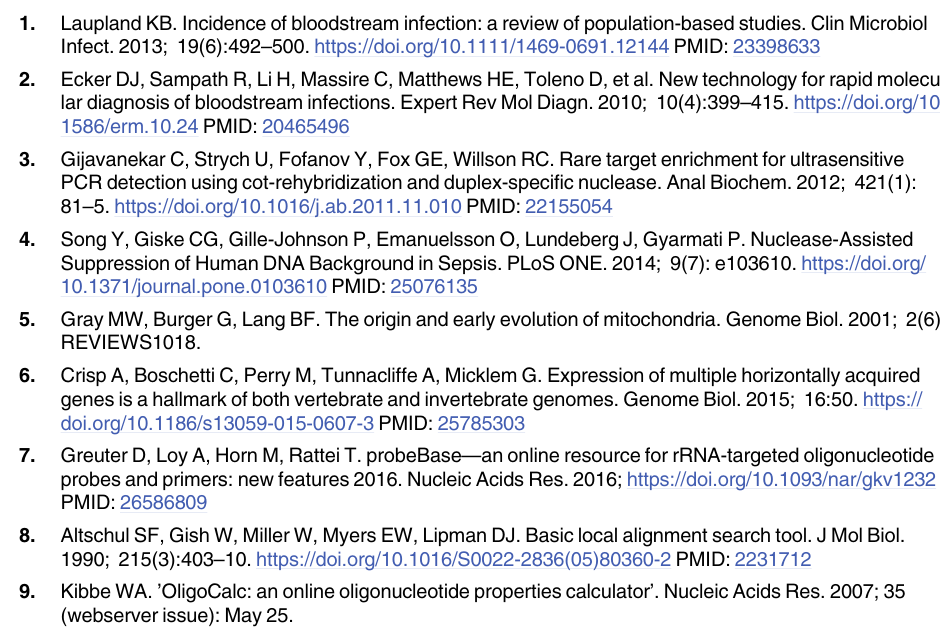
(TIF) S1 Table. Primer sequences and their melting temperatures used in this study.